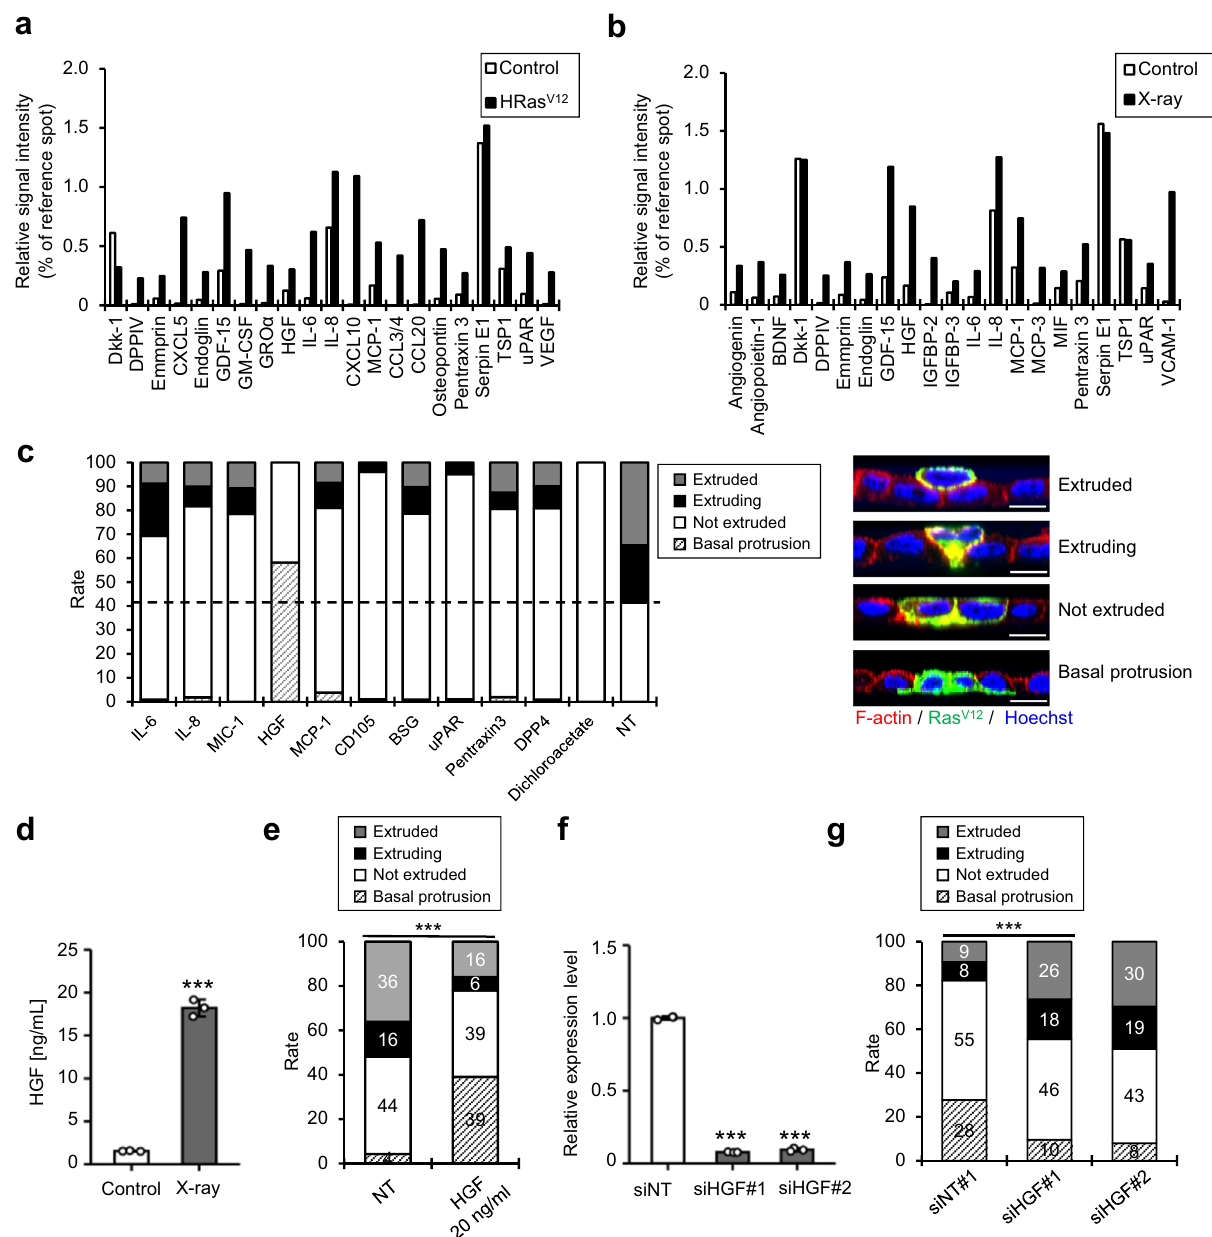
Fig. 2 HGF suppresses apical elimination of Ras V12 cells. a , b Cytokine array analysis of CM derived from oncogene- ( a ) and X-ray-induced ( b ) senescent IMR-90 cells ( a , b , n = 1). Human cytokine array analysis of multiple cytokines secreted by MDCK-pTR GFP-Ras V12 cells after treatment with CM derived from senescent IMR-90 cells. Protein levels are shown as the relative spot intensity (average signal intensity of each spot divided by the control array). c MDCK and MDCK-pTR GFP-Ras V12 cells were treated with 250 ng/ml of each recombinant protein or 50 μ M dichloroacetate, which suppresses the apical extrusion of Ras V12 -transformed cells 17 , for 3 days and mixed at a ratio of 50:1 and cultured on type-I collagen gels. After 16 h of incubation with tetracycline to induce Ras V12 in MDCK-pTR GFP-Ras V12 cells, quanti fi cation of the apically extruded, extruding, not extruded or basally protruded MDCK- pTR GFP-Ras V12 cells from a monolayer of MDCK normal cells was performed. NT nontreatment. Scale bar, 10 μ m. d Analysis of HGF production in X-ray- induced senescent IMR-90 cells using ELISA. Ten days after senescence induction by 10-Gy irradiation, CM was harvested and subjected to ELISA for HGF production analysis. P < 0.001. e MDCK-pTR GFP-Ras V12 cells were treated with 20 ng/ml (control) or 20 ng/ml HGF for 3 days before performing cell competition assay. P < 0.001. f , g Senescent IMR-90 cells induced by oncogenic ras expression were transfected with validated siRNA oligos against HGF twice at 2-day intervals. These cells were then subjected to RT-qPCR for analyzing the expression levels of HGF ( f ). The relative expression level was normalized by siNT cells (siHGF#1, P < 0.001; siHGF#2, P < 0.001). MDCK and MDCK-pTR GFP-Ras V12 cells were treated with CM derived from si control or siHGF-treated oncogene-induced senescent IMR-90 cells for 3 days, mixed at a ratio of 50:1, and cultured on type-I collagen gels. After 16 h of incubation with tetracycline to induce Ras V12 in MDCK-pTR GFP-Ras V12 cells, quanti fi cation of the apically extruded, extruding, or not extruded MDCK-pTR GFP-Ras V12 cells from a monolayer of MDCK normal cells was performed ( g ) ( P < 0.001). Representative data from three independent experiments are shown ( d , e , g ). Error bars indicate the mean ± standard deviation of three independent measurements for all graphs. ** P < 0.01, or *** P < 0.001 by unpaired two-sided t test ( d ), chi-square test ( e , g ), or one-way ANOVA followed by Dunnett ’ s multiple comparisons posthoc test ( f